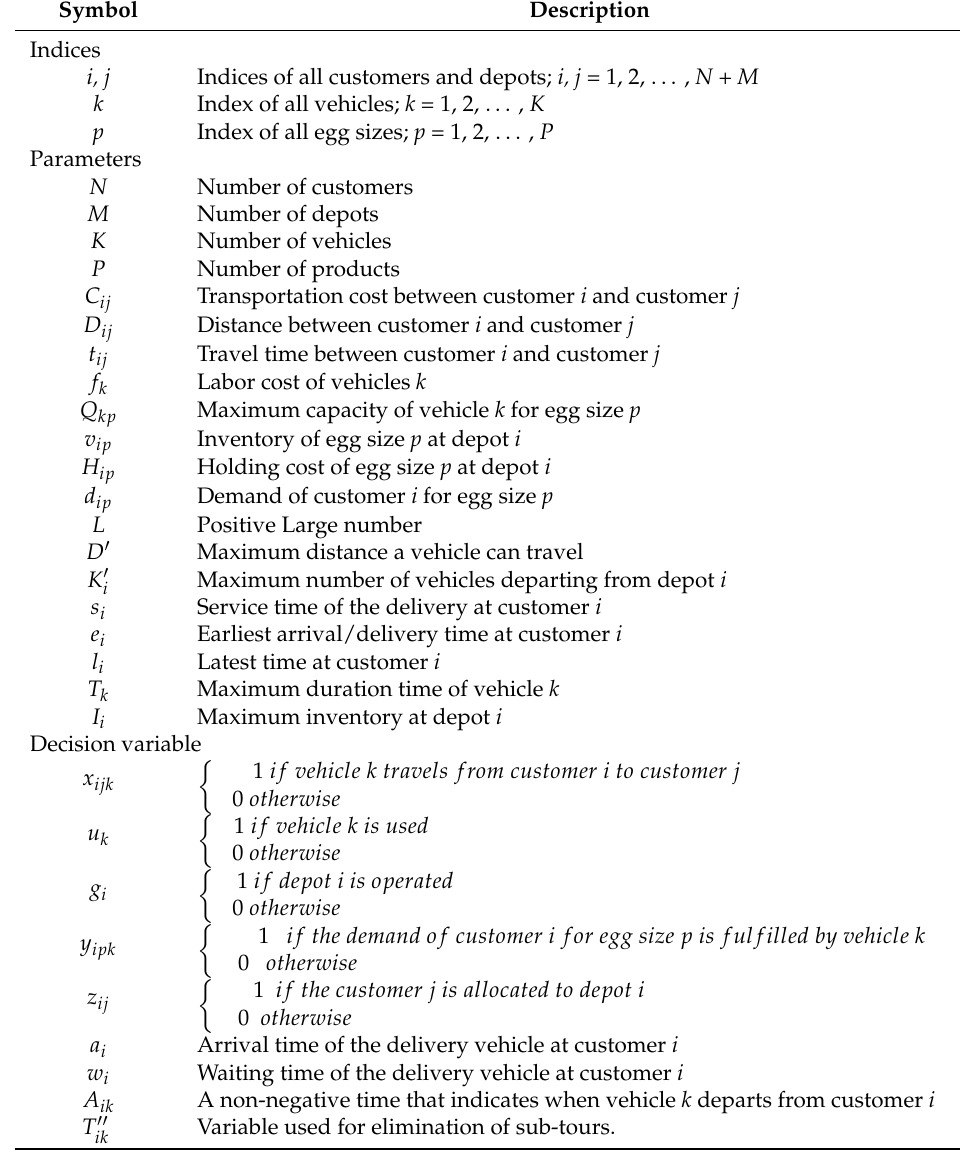
Table 2. Indices Parameters and Decision variable of egg distribution